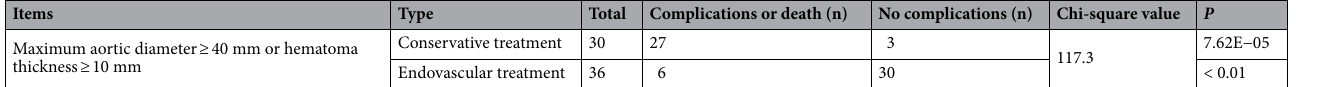
Table 10. Comparison of conservative and endovascular treatment for maximal aortic diameter ≥ 40 mm or hematoma thickness ≥ 10 mm.